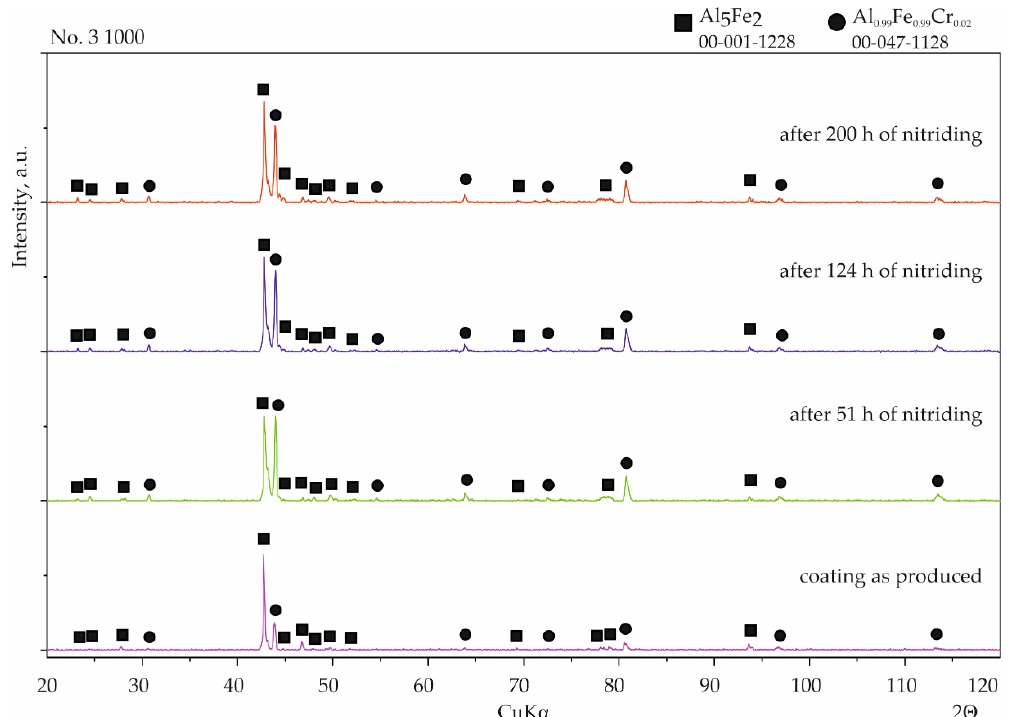
Figure 12. Qualitative X-ray structure analysis (XRD) of the Al-Si coating on 1.4541 steel produced at 1000 °C and 2 h from the bottom: in the initial state; after 51 h of nitriding; after 124 h of nitriding; and after 200 h of nitriding.